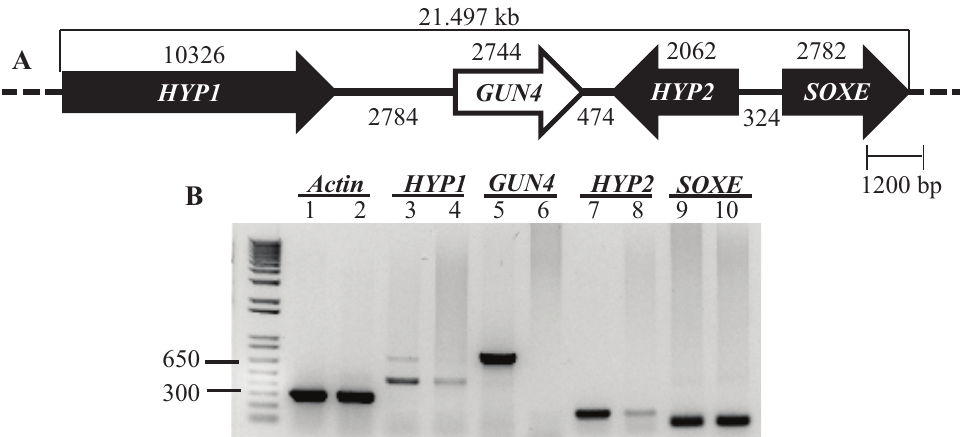
Figure 7. Transcript analyses of GUN4 and its neighboring genes. ( A ) A schematic map of a 21.497 kb genomic region spanning the GUN4 locus on chromosome 5. HYP1 and HYP2 are genes located upstream and downstream of the GUN4 gene, respectively coding for hypothetical proteins. Sulfocyanin ( SOXE ) codes for a blue copper protein. The top black number denotes size of a gene (bp) while the bottom black number denotes distance between genes (bp). ( B ) Semi-quantitative RT-PCR results. Lanes: 1, 3, 5, 7, 9 denote 4A+ cDNA products. Lanes 2, 4, 6, 8, 10 denote gun4 cDNA products. Primer sequences are shown in Table 4. All primers span an intron. Actin was used as a control. Actin genomic product size: 527 bp; Actin cDNA product size: 305 bp. HYP1 genomic product size 726 bp; HYP1 cDNA